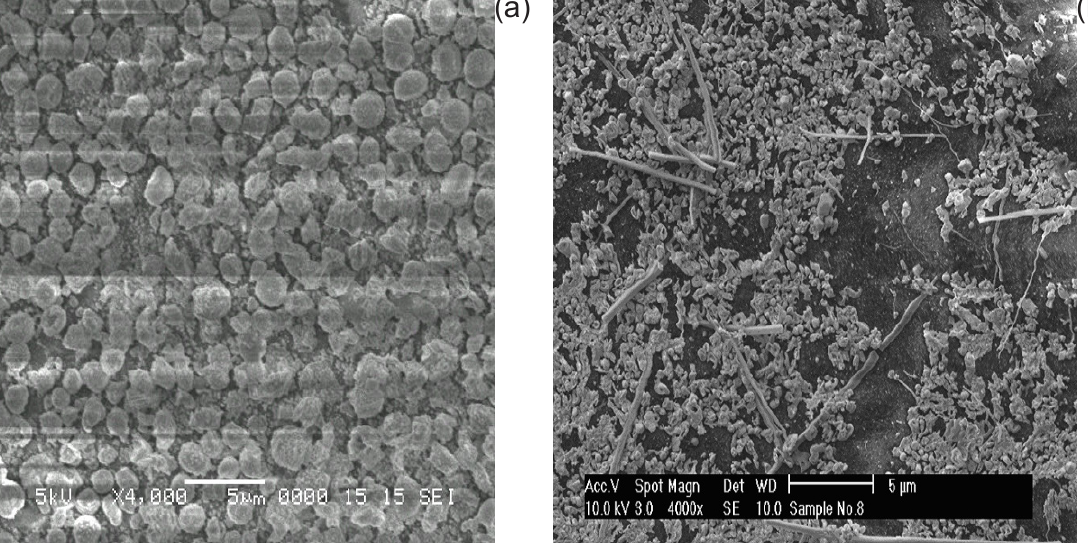
Figure 6. SEM image of Tl